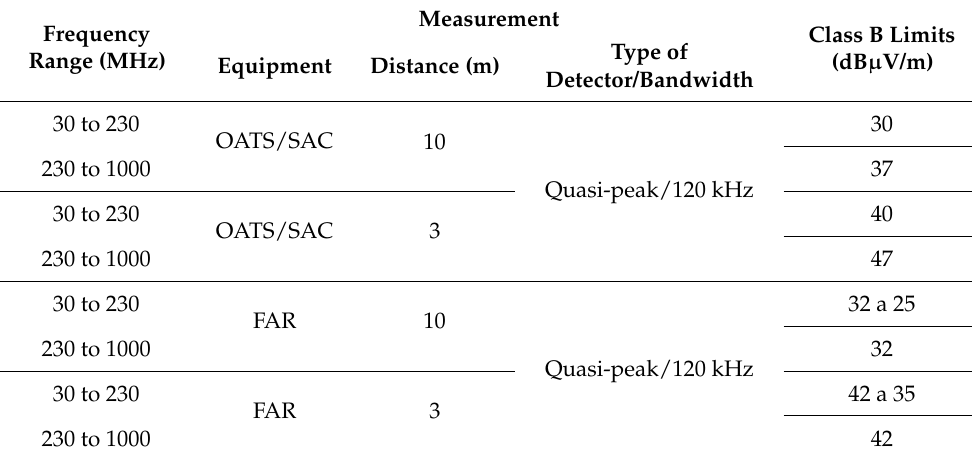
Table 3. General class B limits for radiated disturbances.